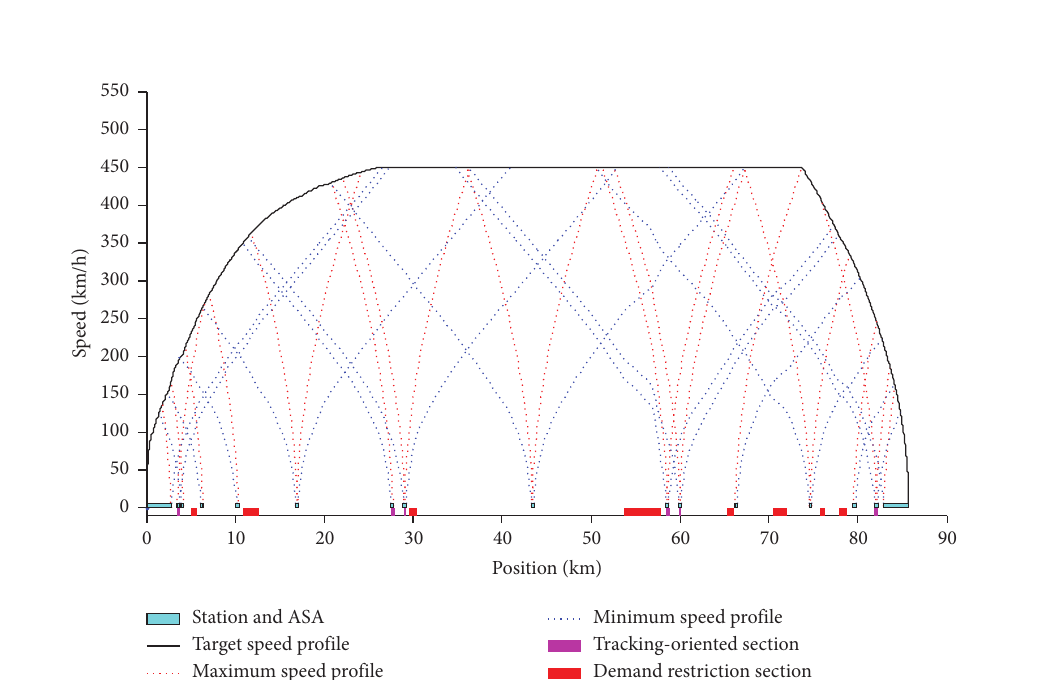
Figure 15: Layout scheme considering the two directions coordinately.